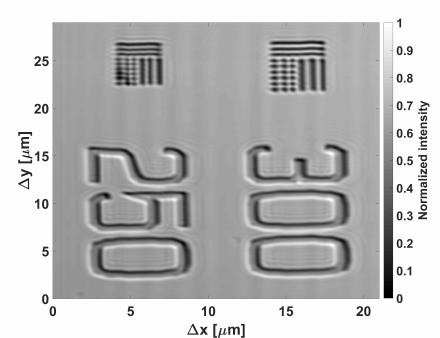
Figure 10. Image of the resolved 250nm structure using a 1 AU pinhole and the PDM far .